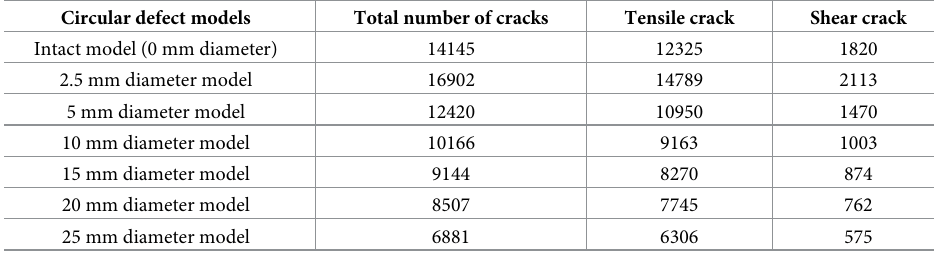
Table 4. Number of cracks developed in each model.